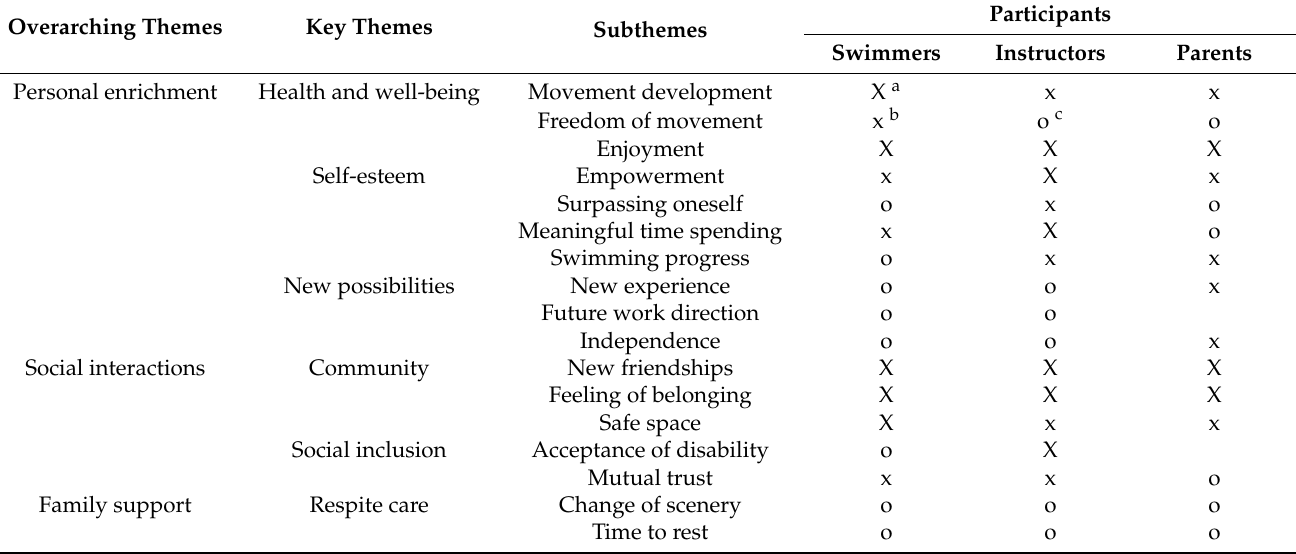
Table 2. Key themes and subthemes mentioned by the